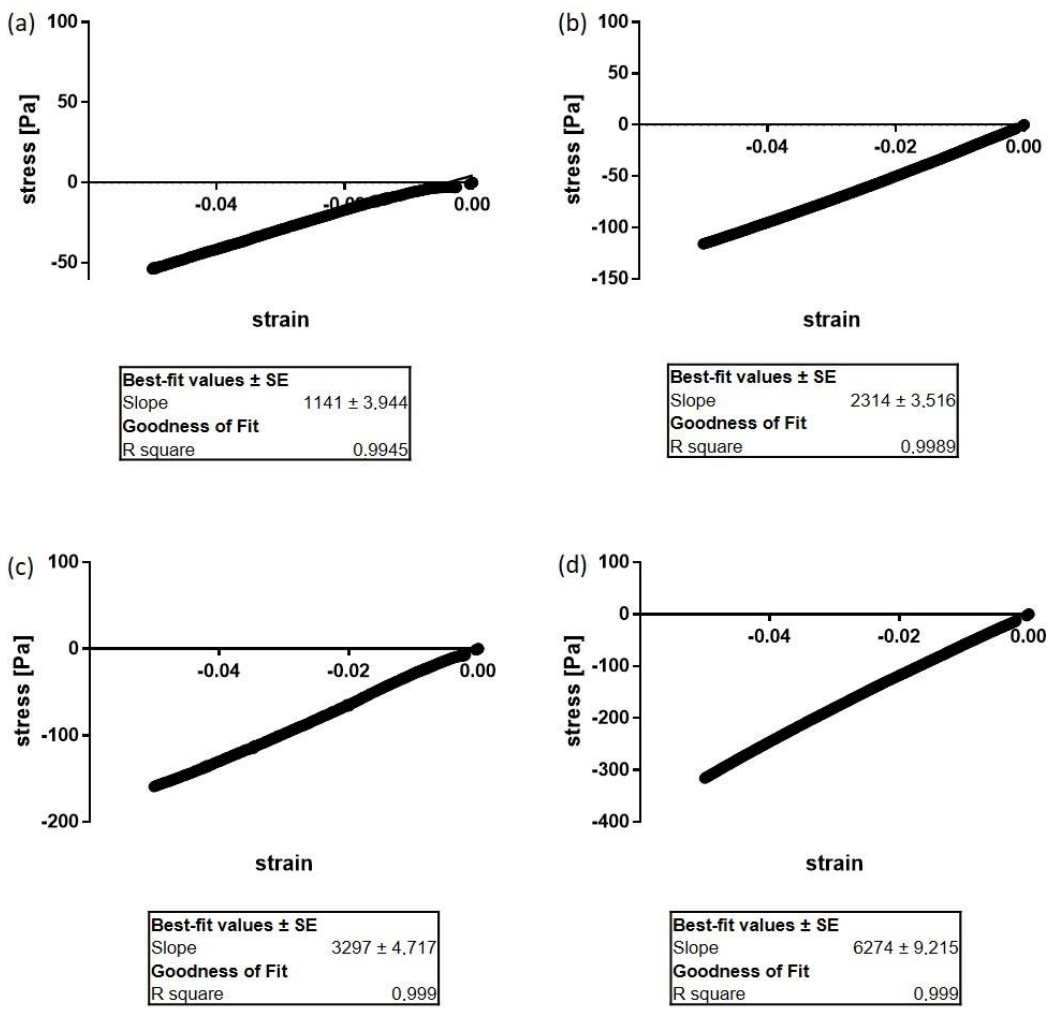
Figure A2. Exemplary graphs for the analysis of the Young’s modulus of HA-DTPH 58% without and with ionic cross-linker (1.0 equivalent ratio to remaining negative charge of HA). Young’s modulus was obtained by a linear fit of the applied strain and measured stress in the viscoelastic region of 0–5%. ( a ) HA-DTPH 58% -Ox ( b ) HA-DTPH 58% -NH 4 + , ( c ) HA-DTPH 58% -GluA + and ( d ) HA-DTPH 58% -dHA + .